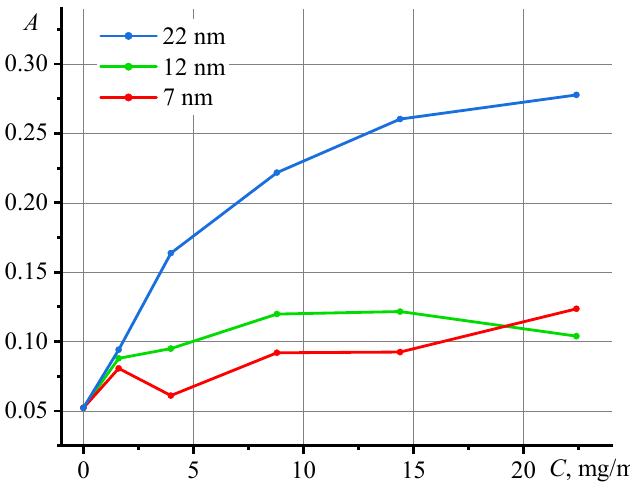
Figure 3. Dependence of absorbance at λ = 532 nm on the concentration of nanoparticles in Ludox dispersions.